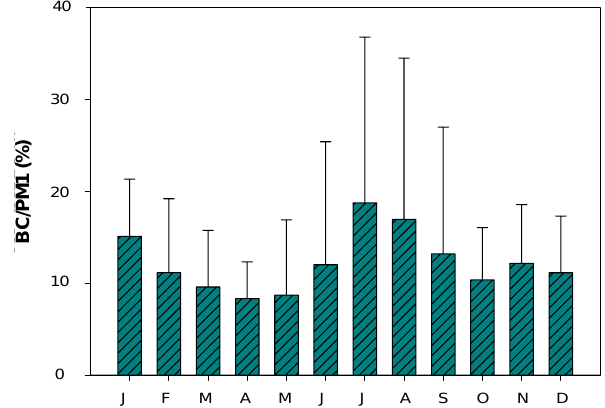
Fig. 3. Annual variation of BC to PM 1 mass fraction (2 year aver- age; error bars represent the standard